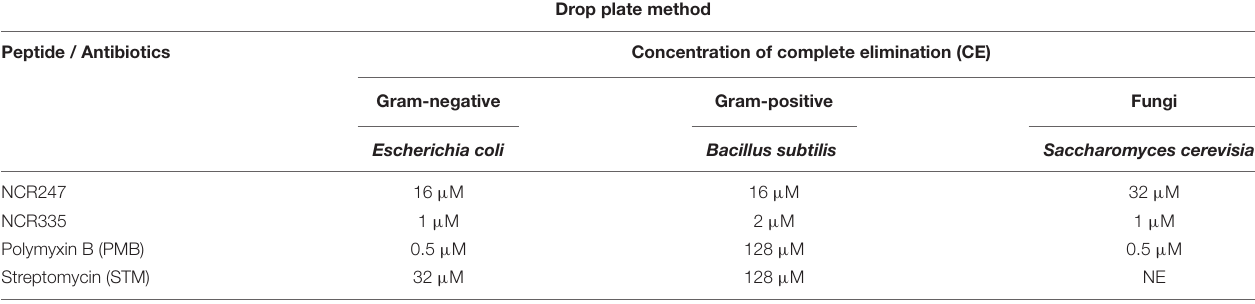
TABLE 4 | Complete elimination concentrations (CE) on E. coli, B. subtilis and S. cerevisiae using drop plate method.